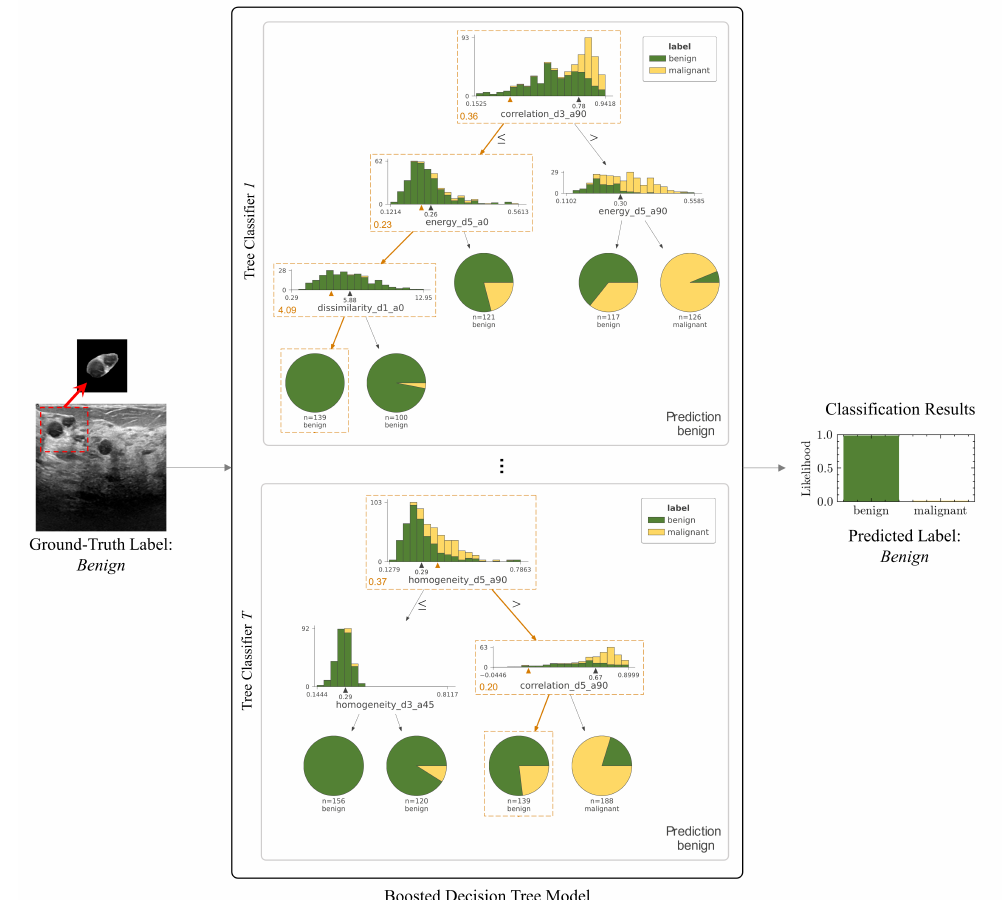
Figure 5. Qualitative results of a benign case. Our pipeline learns to infer a probabilistic diagnosis of the breast ultrasound images. The learned ensemble can be probed to obtain explainable decision paths in a set of learned decision trees. In each learned tree classifier, the orange arrows highlight the decision path. The model learns to compare the texture features obtained from the input image (orange numbers at the bottom of each dashed box) with the learned thresholds (black triangle on each histogram) at each node of the decision